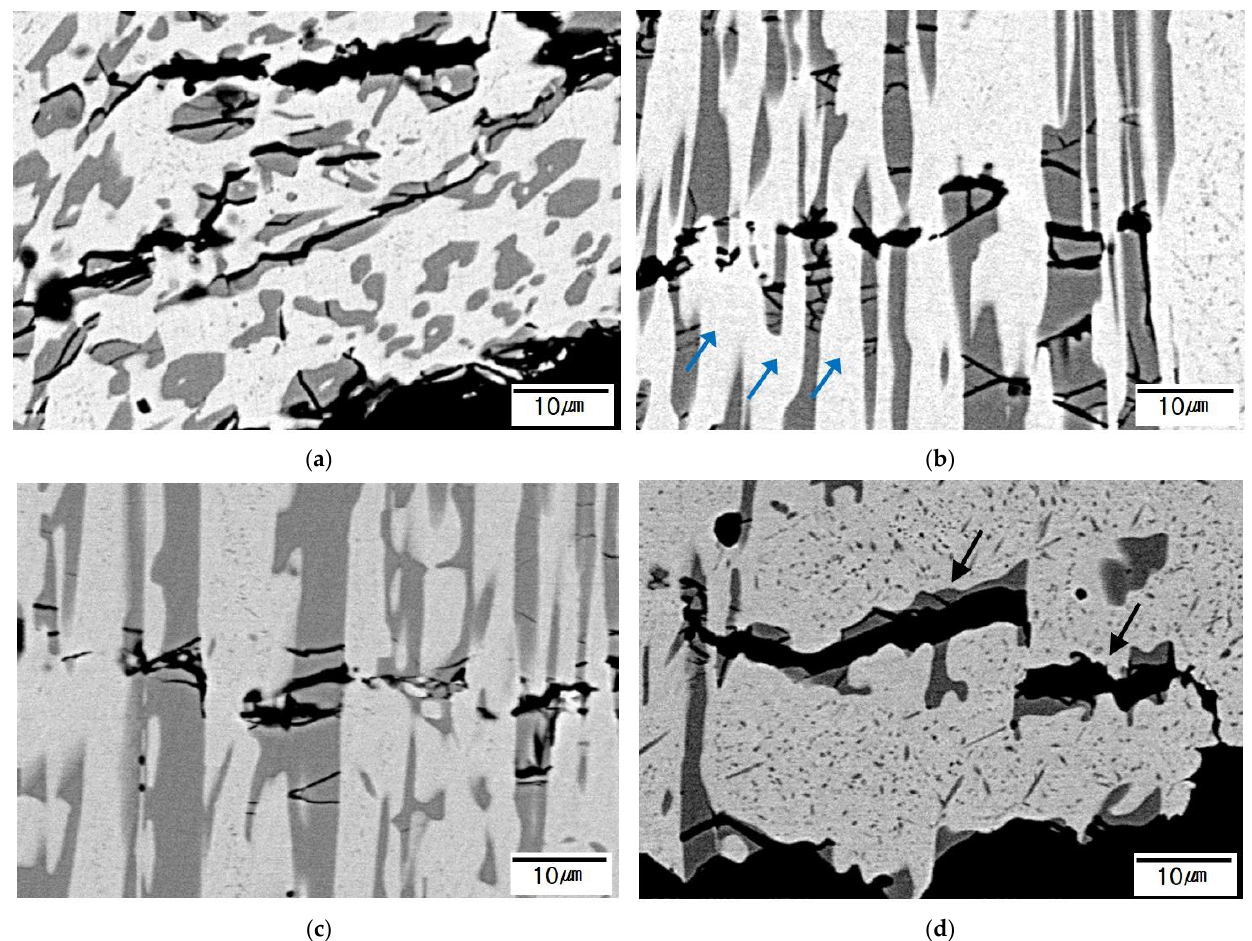
Figure 9. Micrographs showing tensile crack initiations ( a ) equiaxed mother alloy ( b ) 10 µ m/s ( c ) 25 µ m/s ( d ) 50 µ m/s. The blue arrows indicate slip band formed under tensile